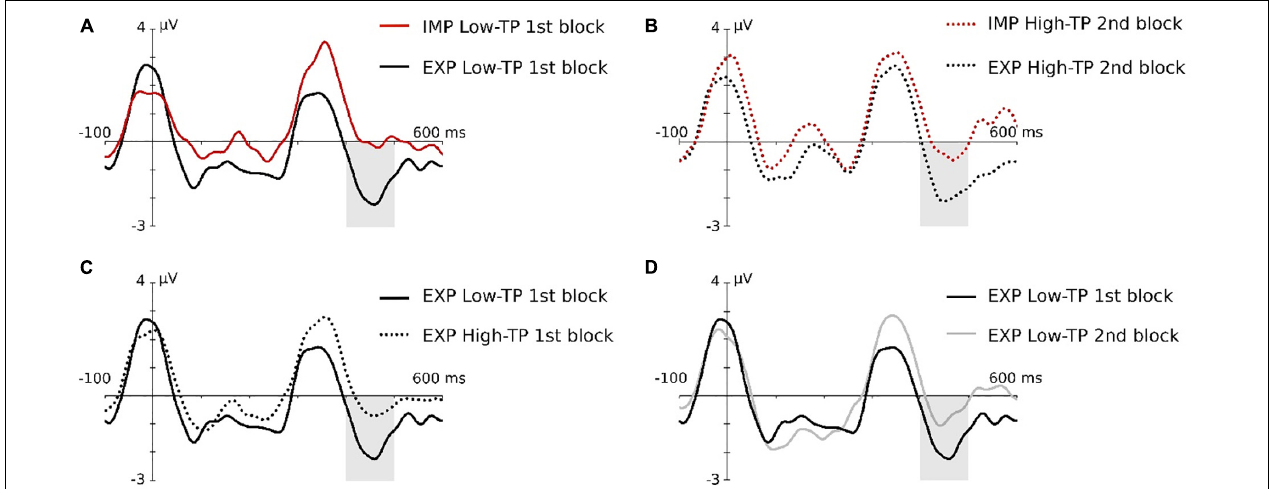
FIGURE 4 | Graphical representation of the N400 triple interaction effect in the children group. Gray-shaded rectangles indicate the N400 time window. (A) Task effect in the low-TP condition, in the first block. (B) Task effect in the high-TP condition, in the second block. (C) Type of “word” effect under explicit instructions in the first block. (D) Effect of block in low-TP “words” under explicit instructions. For a better visualization of the effects, data depicted in this figure were low-pass filtered at 25 Hz after grand